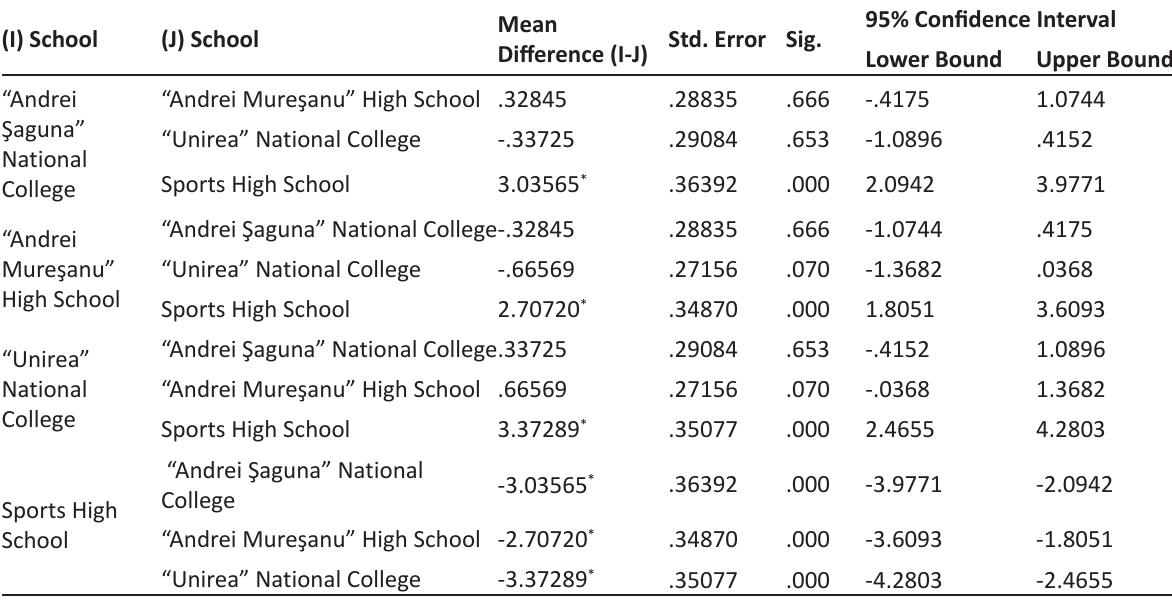
Table 3. Body mass index in female subjects depending on the school – multiple comparisons a with Tukey Hsd